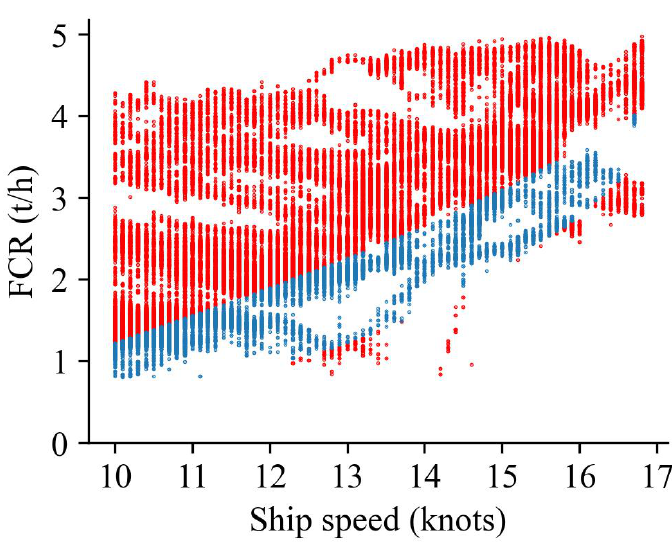
Figure 8. Speed–FCR distribution after Kwon cleaning method (blue